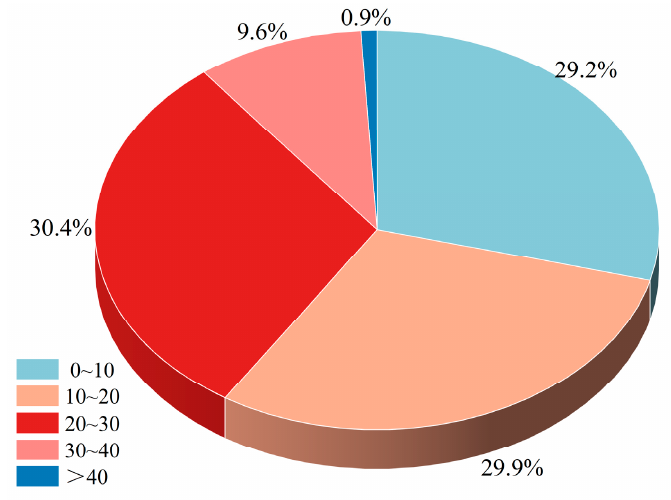
Figure 16. Support resistance frequency statistics